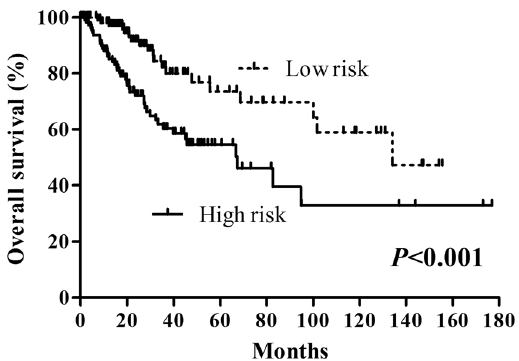
Figure 3. Kaplan-Meier curve for the three-miRNA signature in cervical cancer patients. The patients were stratified into high risk group and low risk group based on